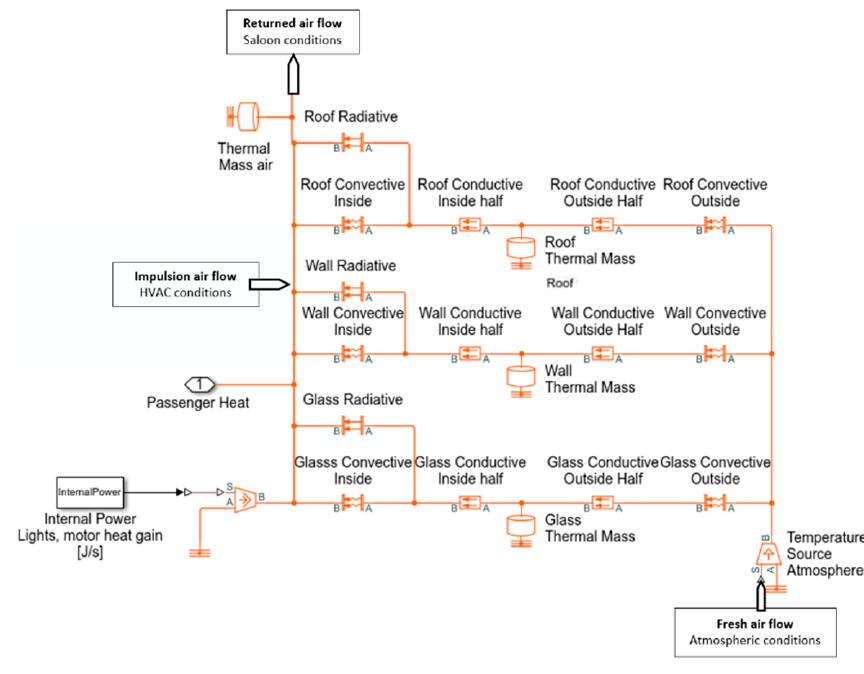
Figure 5 is a block diagram of the cabin thermal networking subsystem showing different heat flows and indicating how the vehicle thermal networking is connected to the HVAC system. The right side of Figure 5 depicts representations of the heat transfer effects from the environment. The heat flows from the subsystems inside the cabin are on the left.